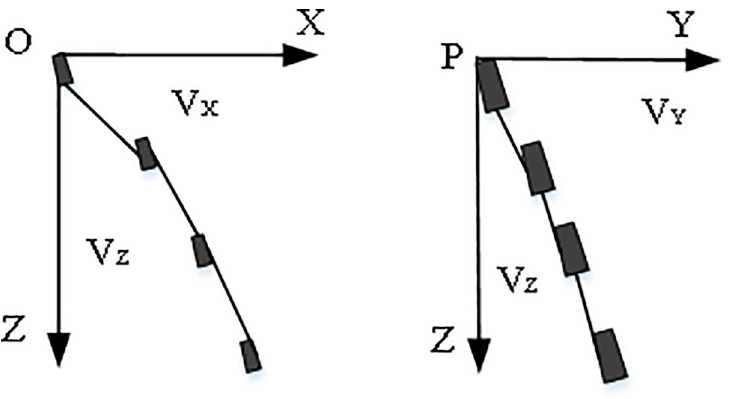
Fig 2. Speed model of the seeding